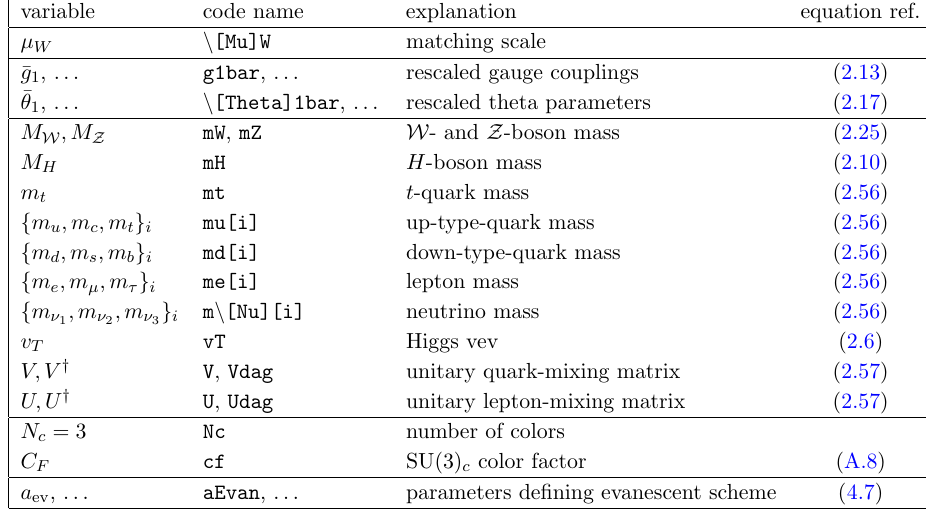
Table 5 . SMEFT variables appearing in the code with the one-loop matching results, which is provided as supplemental